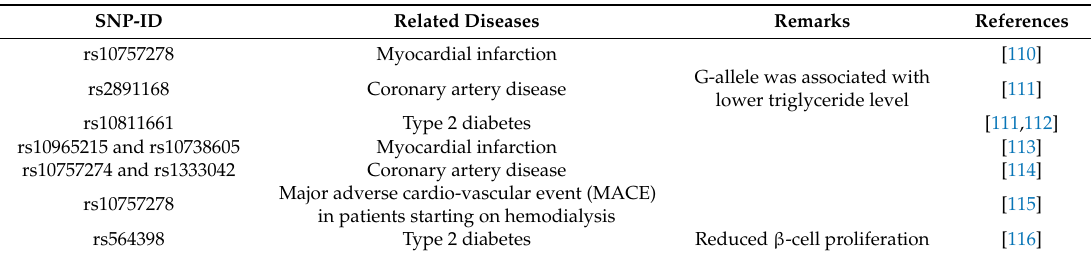
Table 2. Single-nucleotide polymorphisms (SNPs) in ANRIL locus associated with diabetes and cardiovascular